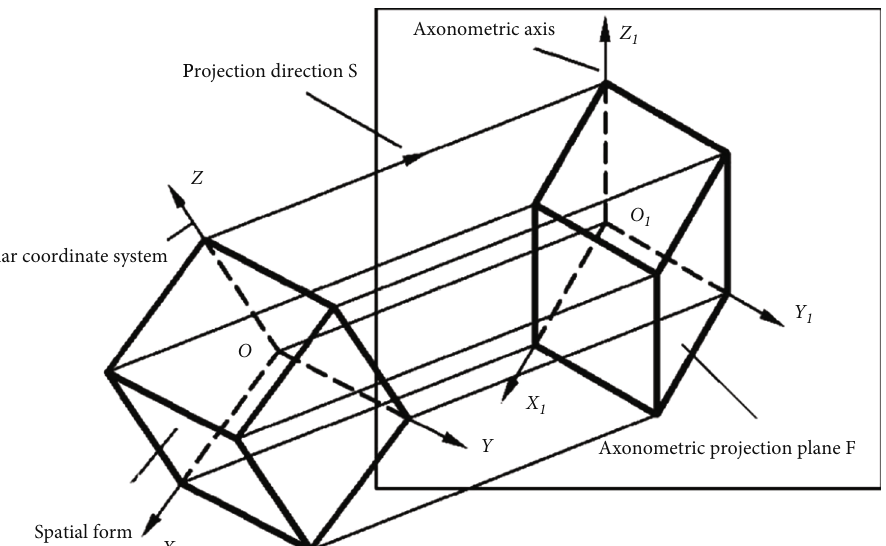
Figure 3: Axonometric projection.